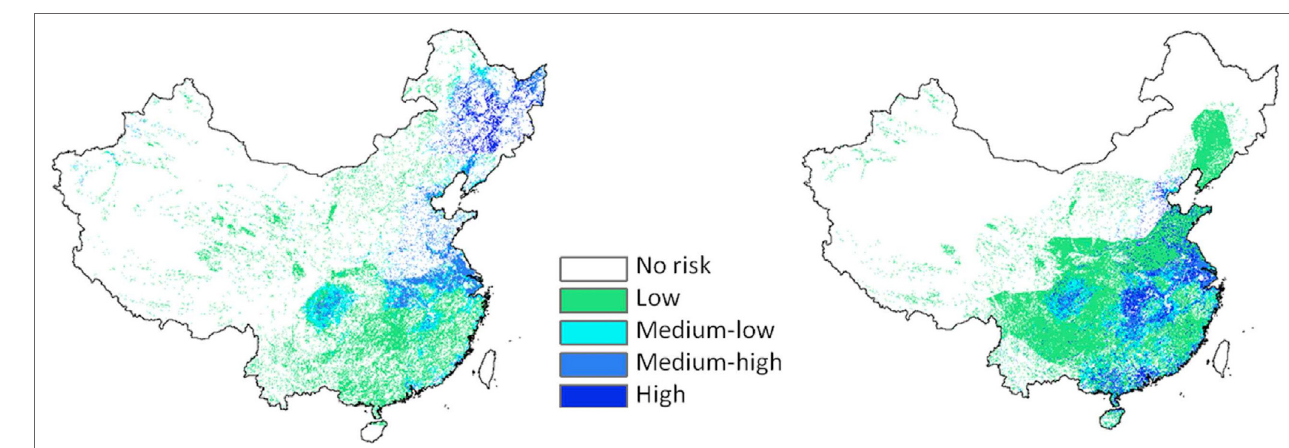
Figure 6 | Risk of domestic-to-wild avian influenza transmission during the breeding (left) and wintering (right) season according to Prosser et al.